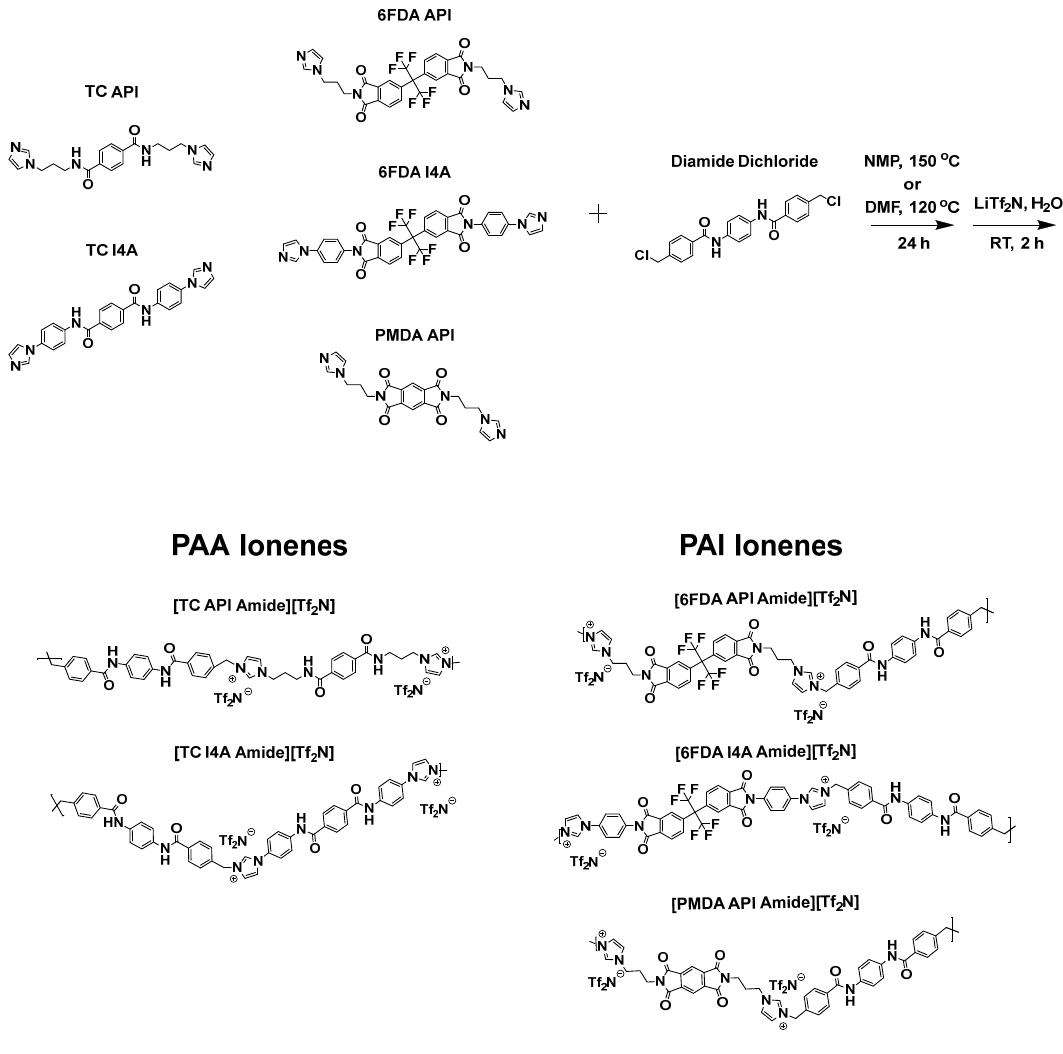
Scheme 1. Synthesis of poly(imide-amide) and poly(amides) from bis(imidazole) and diamide dichloride linkage, polymerized via the Menshutkin reaction.